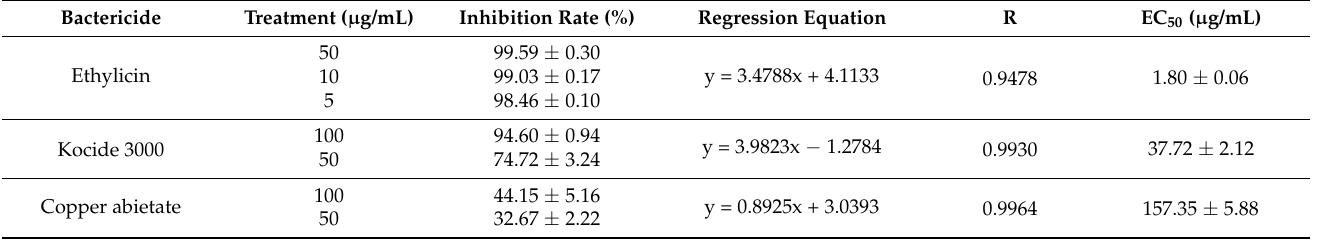
Table 1. In vitro antibacterial effects of three agents on Pseudomonas syringae pv. actinidiae (Psa).